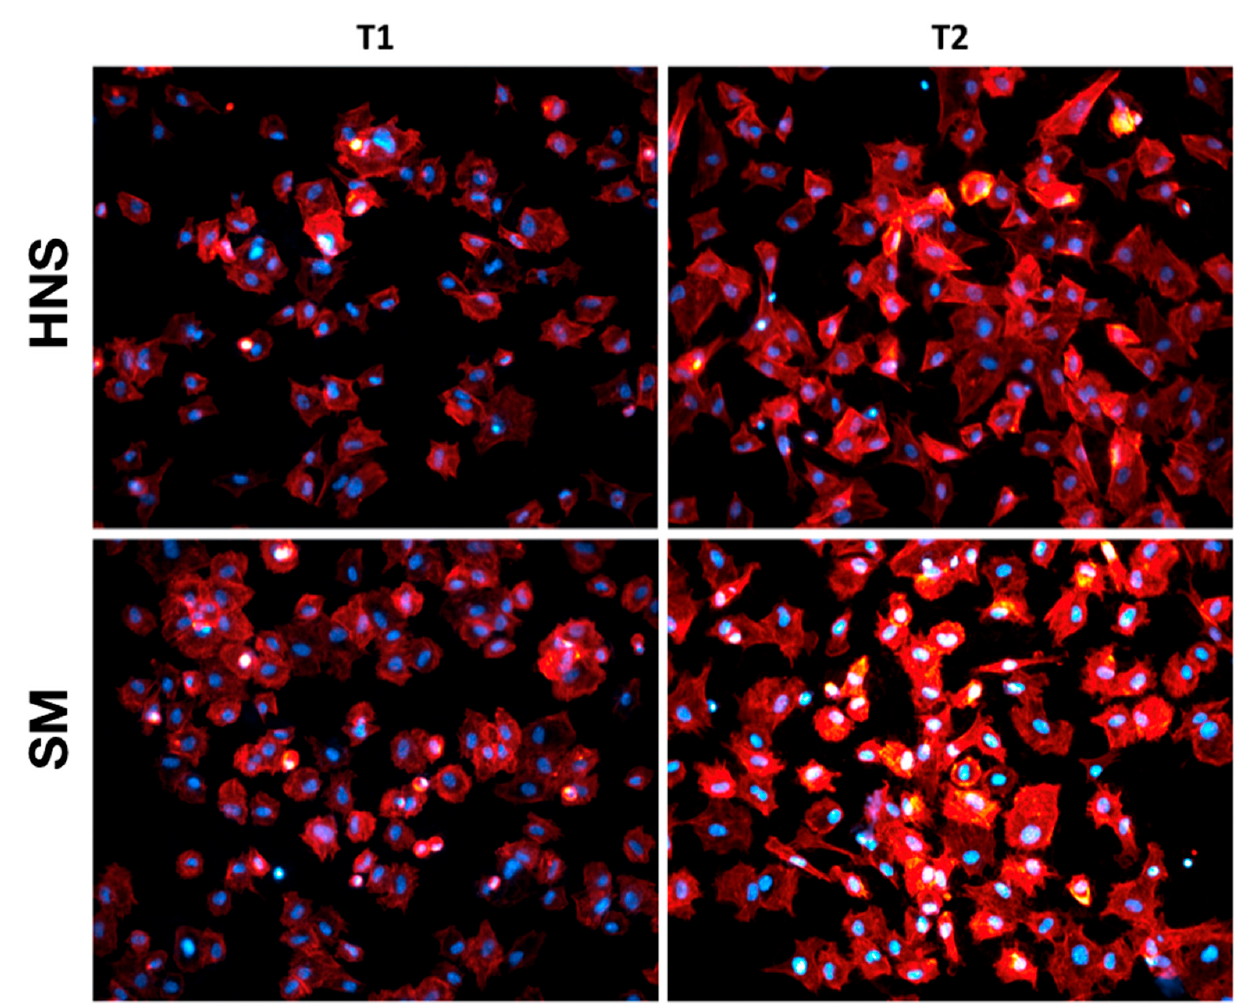
Figure 2. Early cell morphology. Panel depicting the early morphological characterization performed on adherent MC3T3-E1 osteoblasts seed at 2 h (T1) and 6 h (T2) on HNS and SM surfaces. The cytoskeleton is labeled red with Rhodamine-Phalloidin. Cell nuclei are stained blue with DAPI. In order to investigate the morphological differences of the MC3T3-E1 24 h after seed- ing on the different surfaces, different magnifications were considered (100, 200, and 600X). Cells were labeled in order to highlight the cytoskeleton, nucleus, and focal adhe- sion points through paxillin labeling.